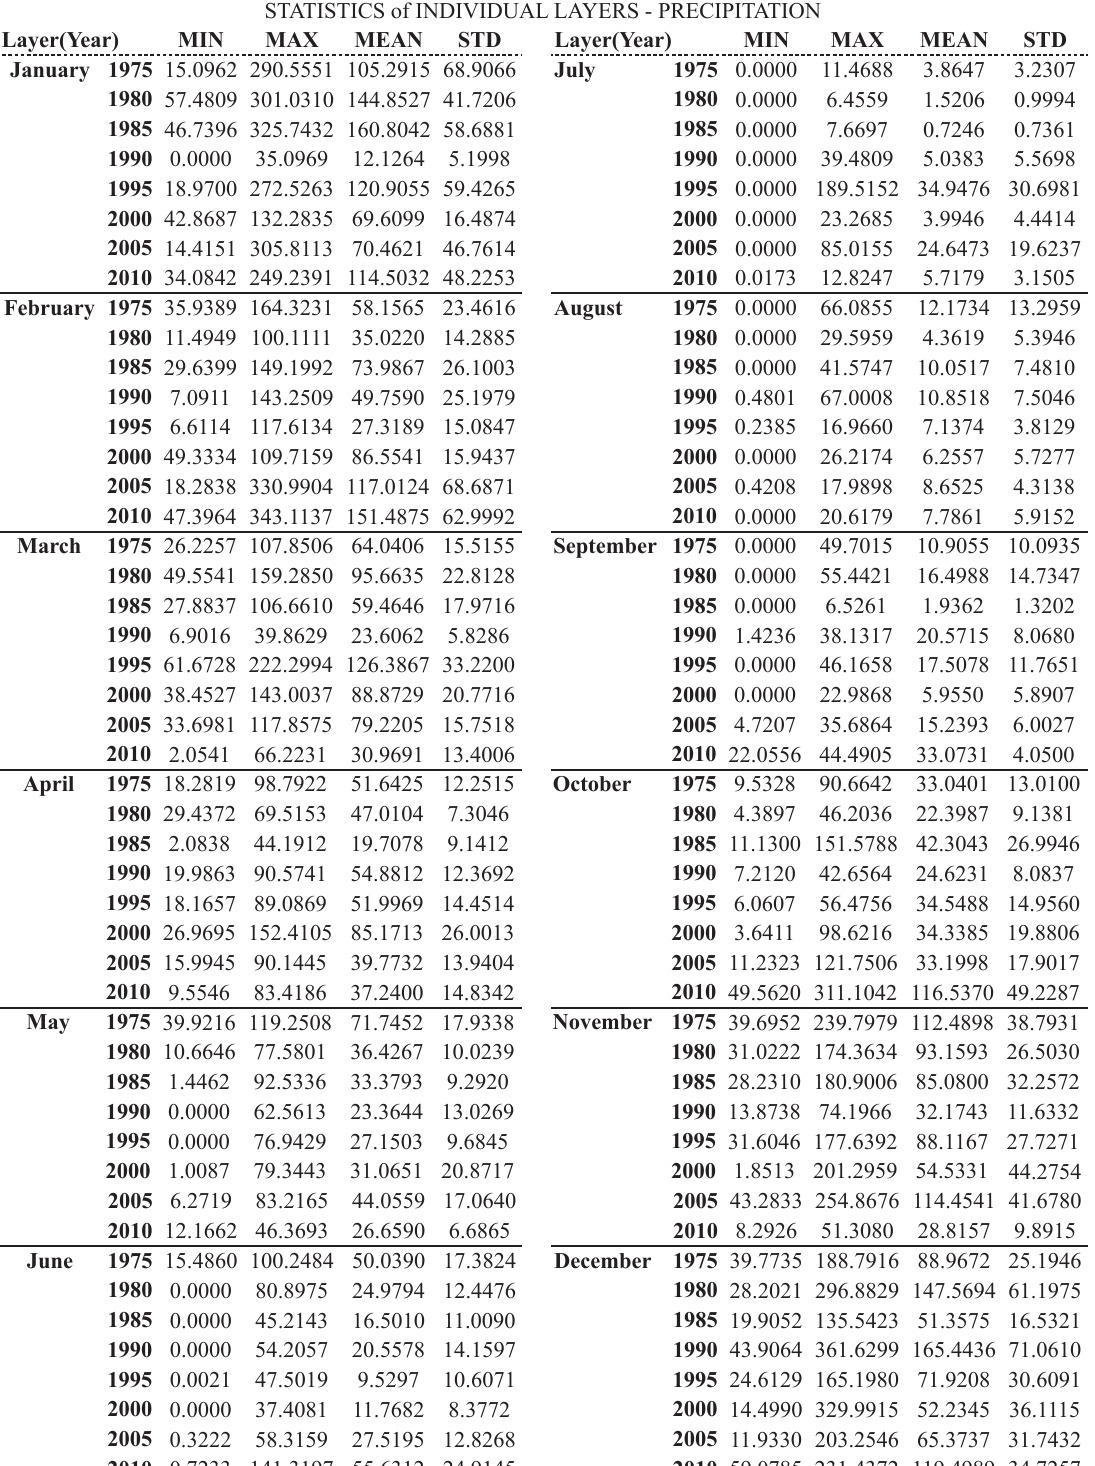
Main statistics for precipitation layers (Minimum, Maximum, Mean, Standard